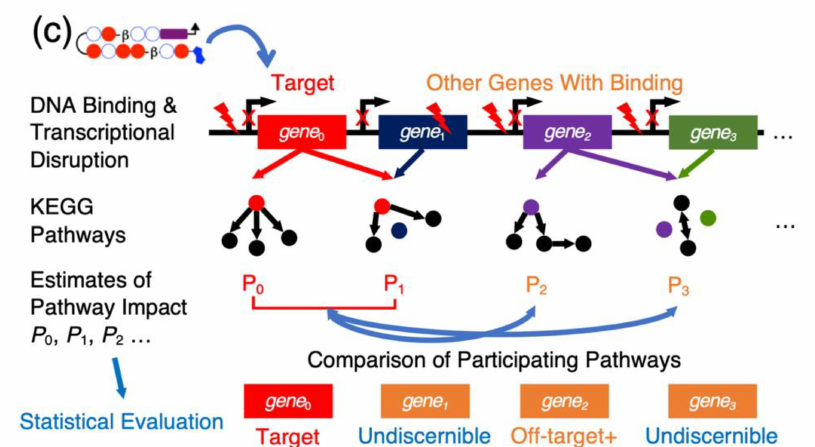
Figure 3. Analyzing o ff -target e ff ects of PIPs with biophysical assays and expression profiling. ( a ) Illustrative use of surface plasmon resonance to compare relative binding specificities of PIPs to DNA containing a particular motif. Evaluation of the polyamides (“Target PIP” and “Mismatch PIP”) rely on di ff erences in the association-dissociation kinetics; equilibrium constants can be estimated based on the trajectories in the sensorgram to elucidate further details about how a particular design variation will a ff ect binding and the extent of binding to mismatched sequences; reproduced from [48], © 2015 (license terms CC BY-NC-ND). ( b ) Illustrative use of circular dichroism to determine the relative di ff erence in PIP-DNA interactions via the monitoring of local conformational changes in the minor groove. The presence of features such as isoelliptic points in the DNA-absorbing wavelength region (230–300 nm) and induced signals near 355 nm indicate a favorable interaction. Comparison of spectra of di ff erent PIP candidates allow comparative assessments to be made. Adapted with permission from [42], © 2015 American Chemical Society. ( c ) A proposed method of determining the candidate of o ff -target genes using expression profiling and the binding site (modified from [49], © 2019 (license terms CC BY); the method utilizes pathway information to reduce the dimensionality of expression arrays to estimate o ff -target e ff ects at the pathway level (illustrated in the example as P 0 , ... , P 3 ). These metrics could then be used to compute overall changes that may be deconvoluted later on to identify potential o ff targets (“O ff -target + ” in orange) from genes that were somehow impacted as a consequence of other on-target and o ff -target genes in the pathway (“Undiscernible” in